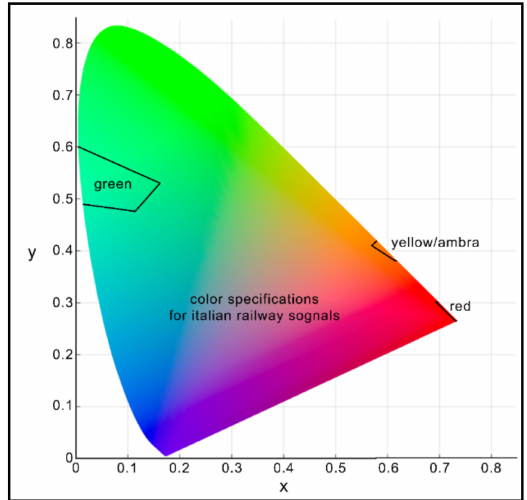
Figure 1. Commission Internationale d’Eclairage (CIE) chromaticity areas for red, yellow, and green aspects of the Italian railway signaling.